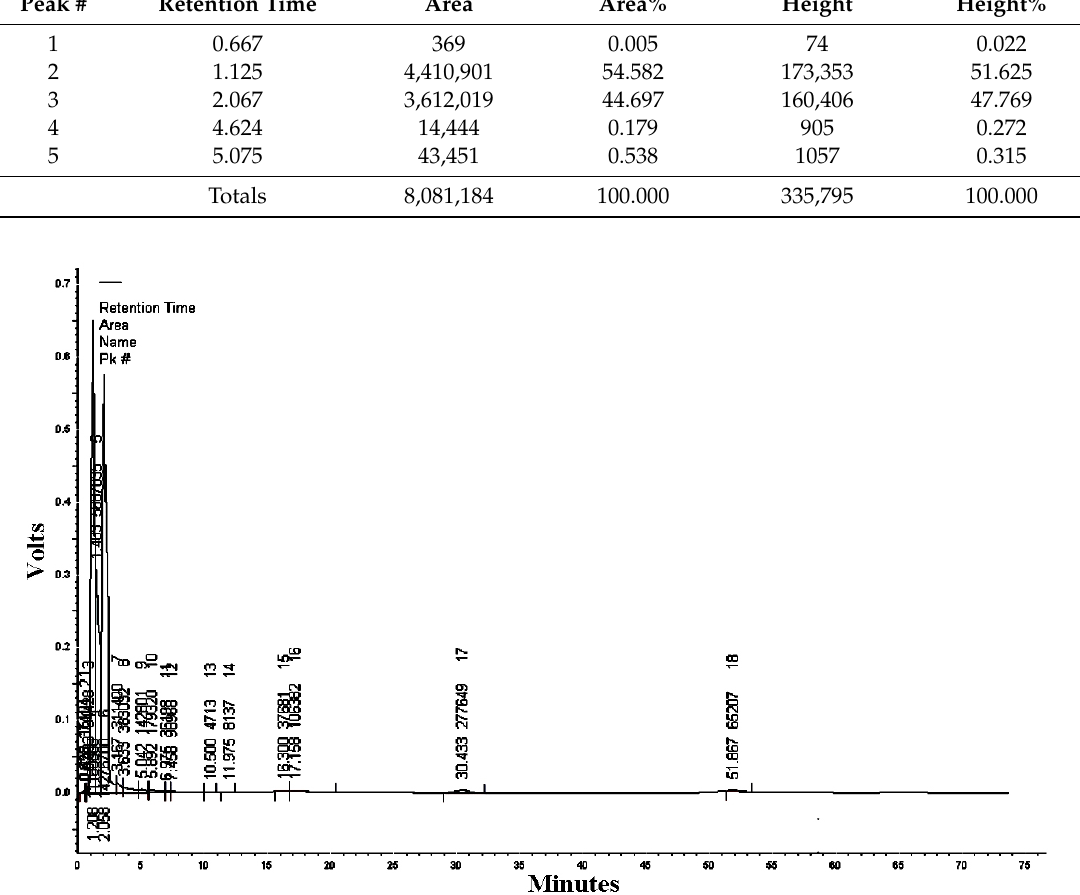
Table 4. Retention time, area, area %, height, and height % of the peaks separated by High-performance liquid chromatography / ultraviolet-visible (HPLC / UV-VIS) data of Ricinus communis leaf ethanol extract at the wavelength of 300 nm.